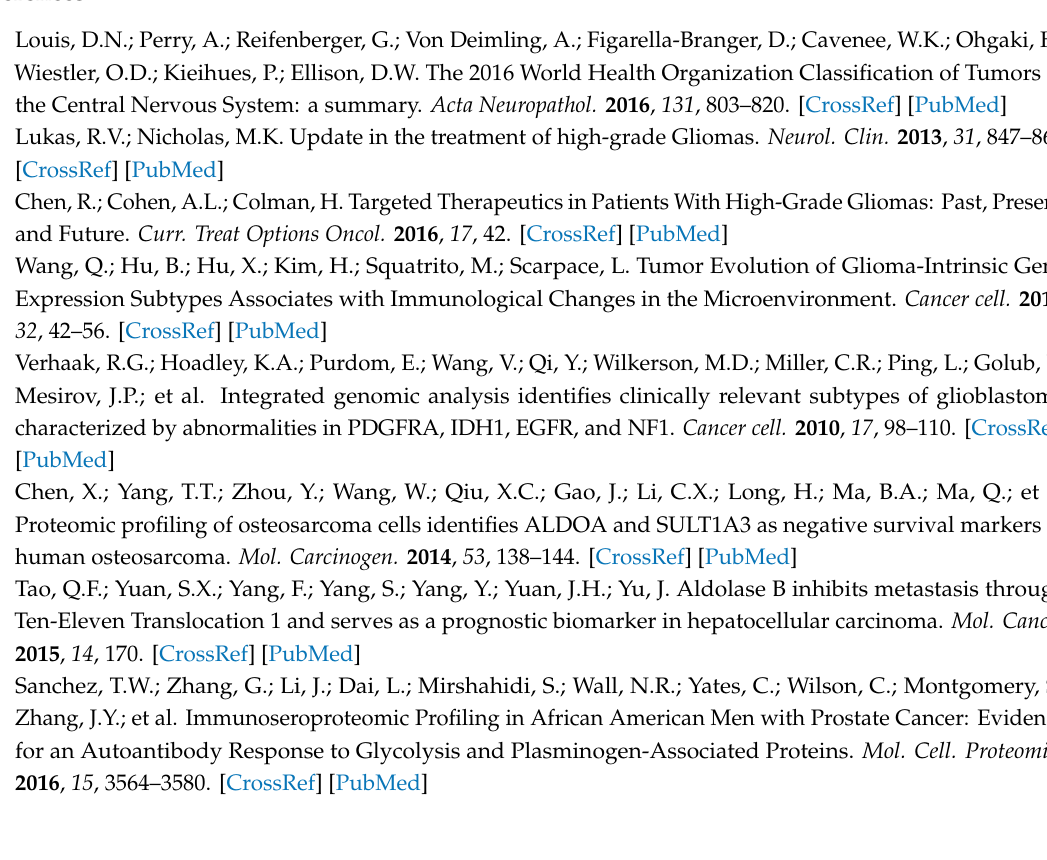
Figure S1: A heat map showing the endogenous mRNA expression level of CD44 (marker of mesenchymal type), and the non-mesenchymal marker OLIG2 in The Cancer Genomics Atlas (TCGA)_Glioblastoma patients by molecular pathology classified ( n = 538). Figure S2: ( A ) The expression of IDH1 and ALDOC in the glioma cancer cell lines panel. ( B ) The correlation between the ALDOC mRNA level and the expression level of IDH1 in glioblastoma cell patterns from the Cancer Cell Line Encyclopedia (CCLE) cohort. Figure S3: Boxplot showed the distribution of ALDOC expression in clinical patients according to the IDH1 mutant event in the GSE36245 cohort ( p = 0.0384). Figure S4: ( A ) A heat map showing the endogenous mRNA expression level of Aldolase family members ALDOA , ALDOB, and ALDOC in GSE16011 ( n = 284). ( B ) A boxplot showing the distribution of ALDOC expression in clinical patients according to the normal tissues and tumor parts in the GSE16011 cohort ( p = 0.0108). ( C ) A heat map showing the endogenous mRNA expression level of Aldolase family members ALDOA , ALDOB, and ALDOC in GSE54077 ( n = 7). Figure S5: ALDOC protein level by immunohistochemistry in representative brain tumor tissues. Figure S6: Representative Giemsa staining to estimate the invasion abilities of LN-229 and T-98G cells with forced expression of the vector control or exogenous ALDOC gene, respectively. Table S1: Clinical relevance of ALDOC expression in glioblastoma (GBM)